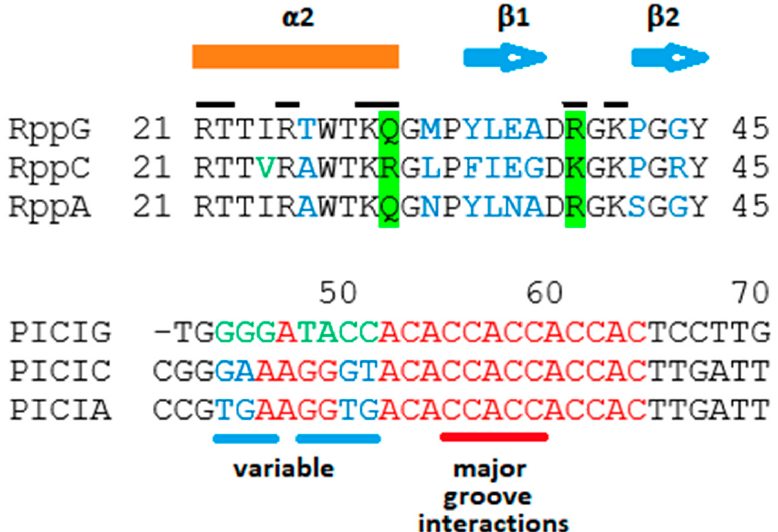
Figure 4. Possible recognition specificity of PICI’s R3 and their correspondent Rpps. (Top) Alignment of studied Rpps (RppB has an identical residue sequence to RppA in the shown region). The bar on top shows the extent of the α 2-helix and the arrows those of the β -sheets. The lines on top of the one-letter code show the residues that have been proposed to interact with bases in R3. Of those residues, the ones highlighted in green differ between RppC and the other Rpps. Therefore, they may provide R3-binding specificity. The residues in blue show differences in other regions, and some of them may provide specificity for RppG and RppA to discriminate from PICIG- and PICIA-R3s. Notice that most of the divergence is in the α 2-helix– β 1-sheet link, especially in the β 1-sheet itself and in two residues of the β 2-sheet. (Bottom) Alignment of the correspondent R3 regions of cosB PICIs. Red bases show identity, blue ones show differences between A- and C-R3s, and green bases show difference between PICIG-R3 and the other two Rs. Notice the striking identity in the 3 (cid:48) part and the deviation in the 5 (cid:48) portion. The sequence that varies between the PICIs R3 are underlined in blue. The base pairs that are supposed to interact with Rpps residues in the major groove are underlined in red.